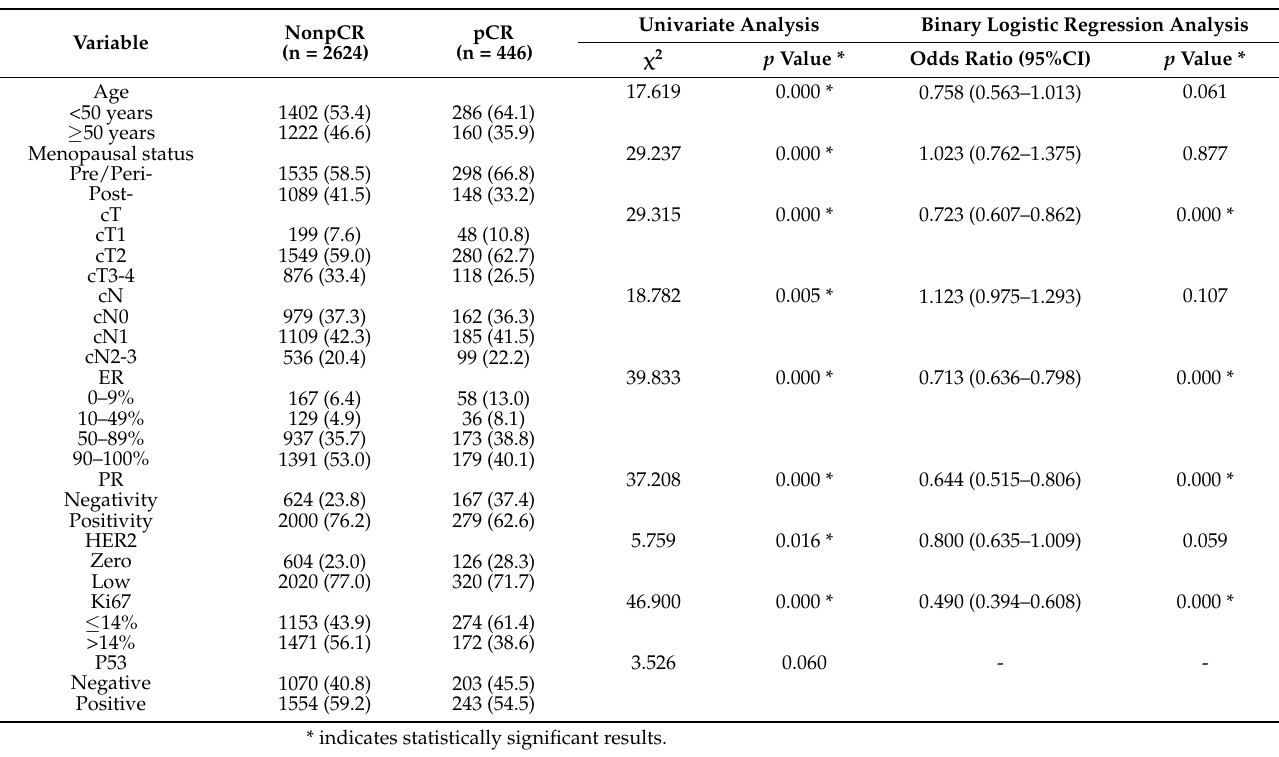
Table 3. Patient characteristics stratified by pCR status (non pCR vs. pCR).